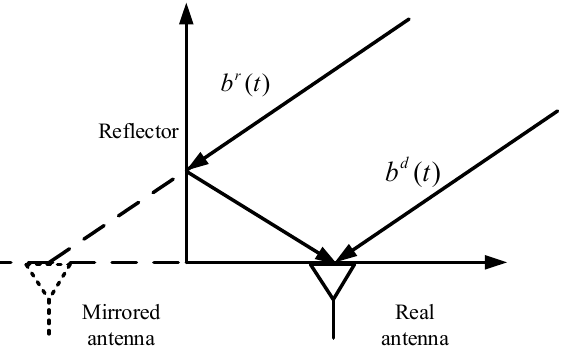
Figure 2. Signal propagation of 1-D MAS.